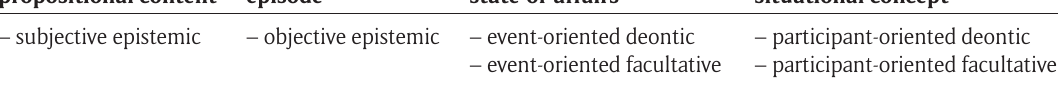
Table 2: Modality in